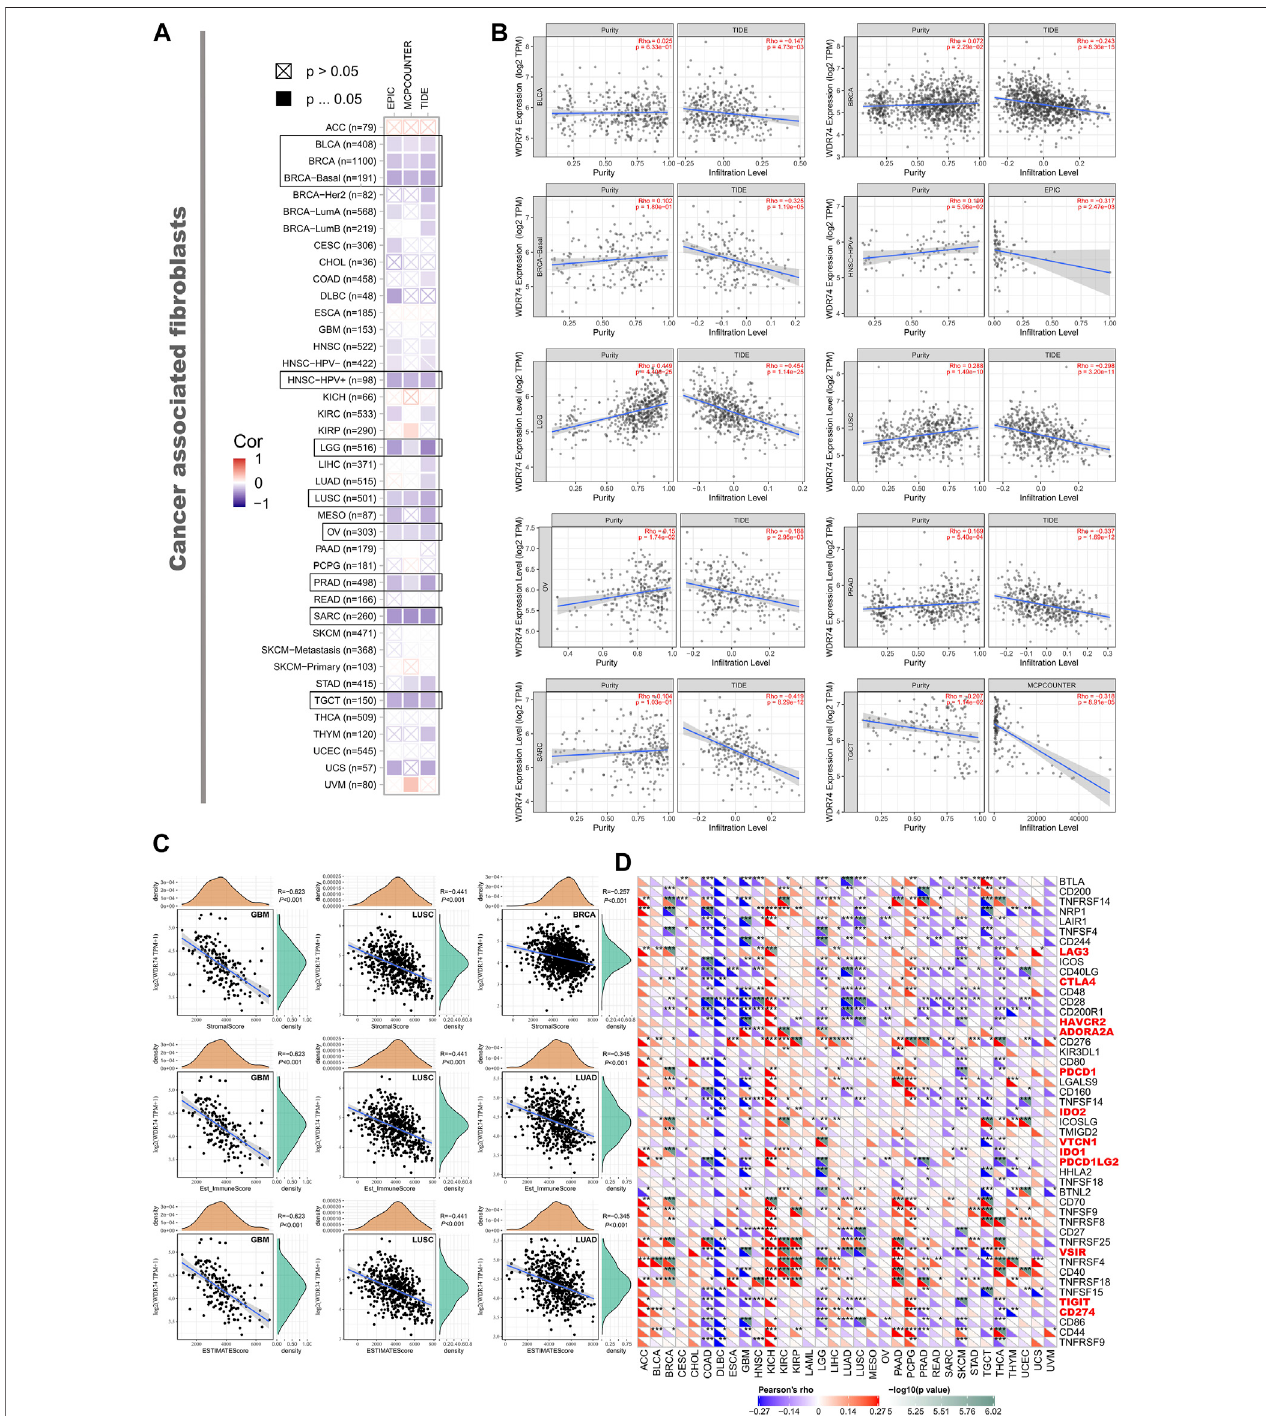
FIGURE4| Weapplieddifferentalgorithmsto fi gureoutthepotentialcorrelationbetweentheexpressionlevelofthe WDR74 geneandthein fi ltrationlevelofcancer- associated fi broblastsinTCGAcancers (A) .Thecorrelationbetween WDR74 expressionandtheestimatedin fi ltrationvalueofcancer-associated fi broblastsisshownas a scatterplot in BLCA, PRAD, SARC, and LUSC (B) . The correlation analysis of ImmuneScore, StromalScore, and EstimateScore with WDR74 expression in GBM, LUSC, BRCA, and LUAD is shown as a scatterplot (C) . We also explored correlation between WDR74 expression and immune-related cytokines and immune checkpoint expression across 33 TCGA tumors (D)